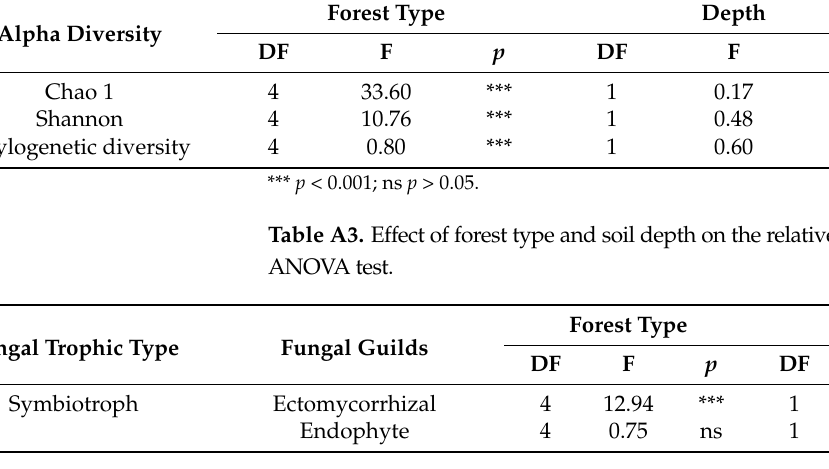
Table A2. Effect of forest type and soil depth on alpha diversity in the two-way ANOVA test. Alpha Diversity